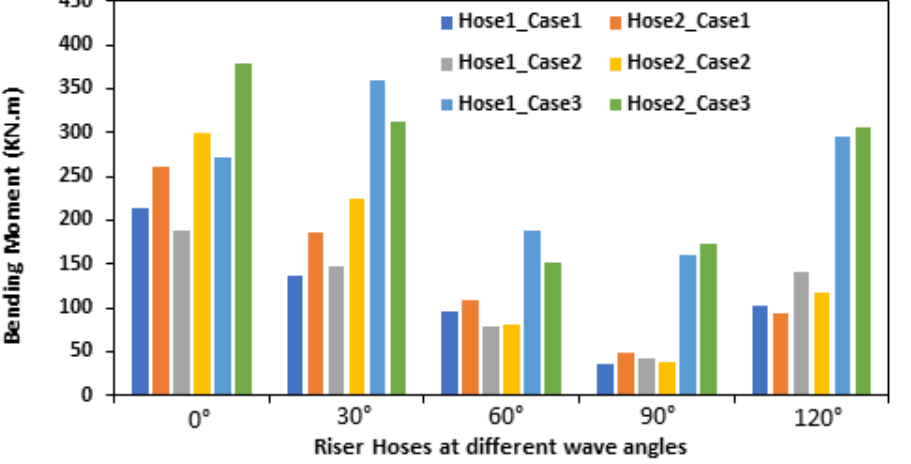
Figure 20. Bending moment profile for coupled model showing Hose1, Hose2, three sea states and five wave angles.